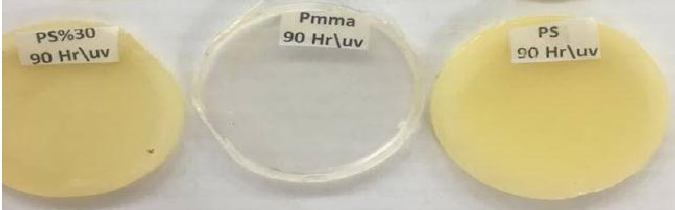
Fig.5: Shows 90hr uv for PMMA, PS, 30%PMMA\PS.